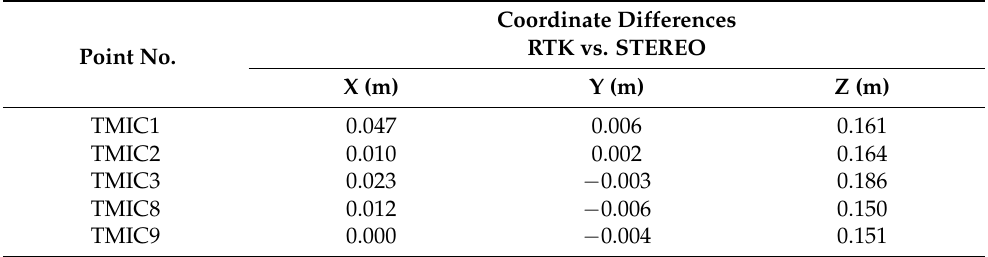
Table 12. Coordinate differences between KINEMATIC (RTK) and STATIC measurements, resulting from field measurements and